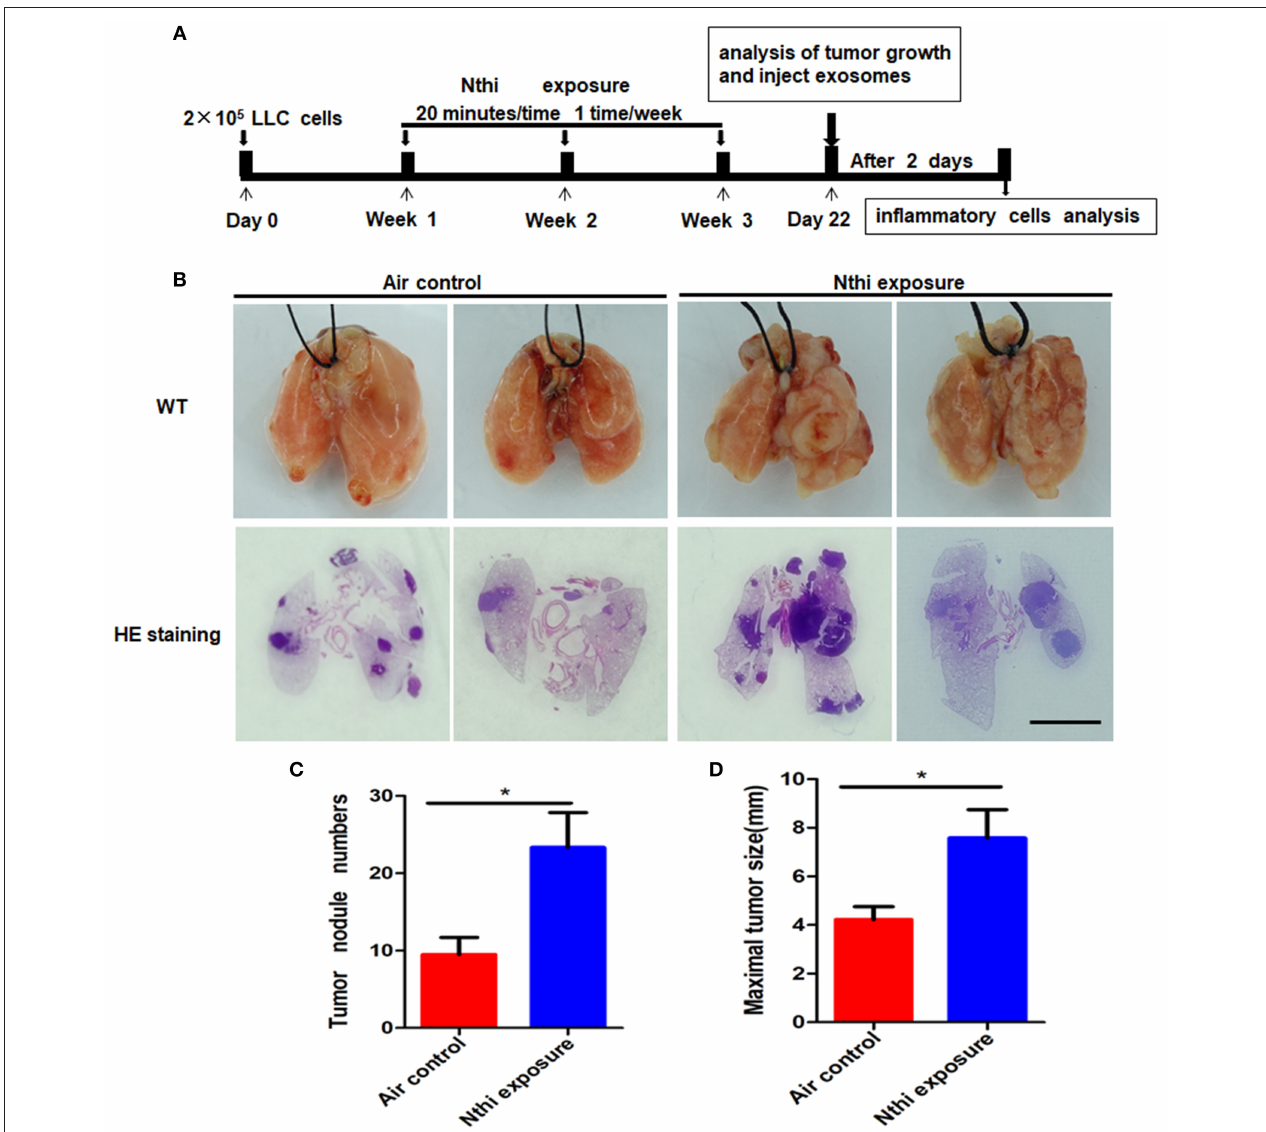
FIGURE 1 | Exposure to NTHi lysate promotes the development of lung tumor. (A) Scheme of experimental protocols for the promotion of NTHi-induced lung cancer. (B) Lung appearance and histology in WT mice 3 weeks after initiation of the NTHi lysate exposure protocol. Scar bar = 100 µ m. (C,D) The number of tumor nodules and the maximal tumor diameter detectable on the surface were determined. Results are means ± SEM ( n = 7), * P < 0.05.